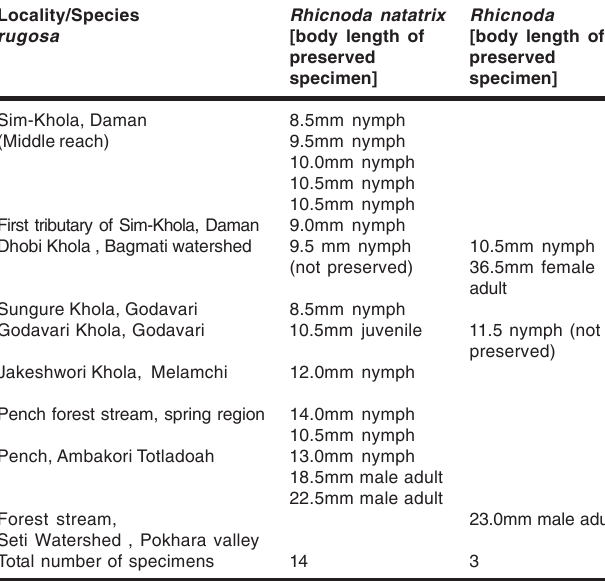
Table 1. Investigated Specimens of Rhicnoda spp. from Nepal and India